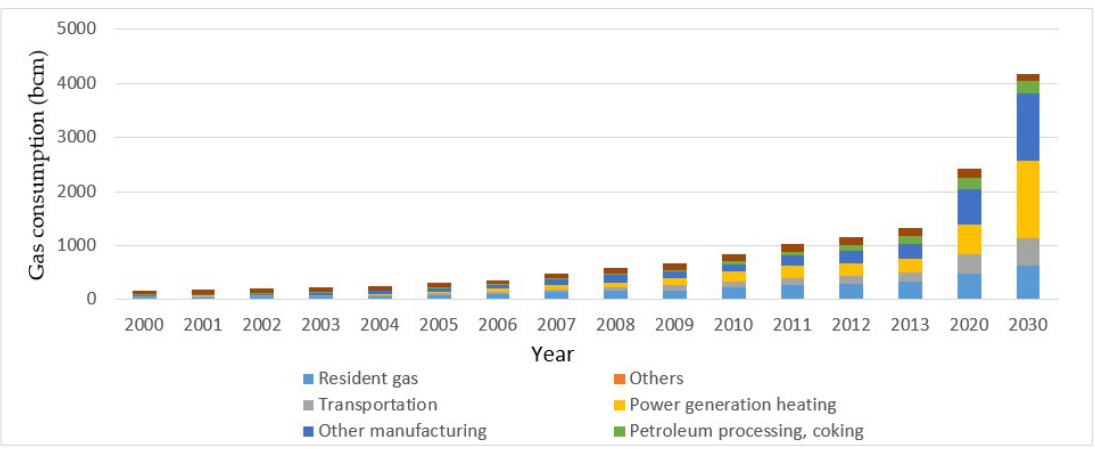
Figure 10. Sub-industry natural gas demand in China.